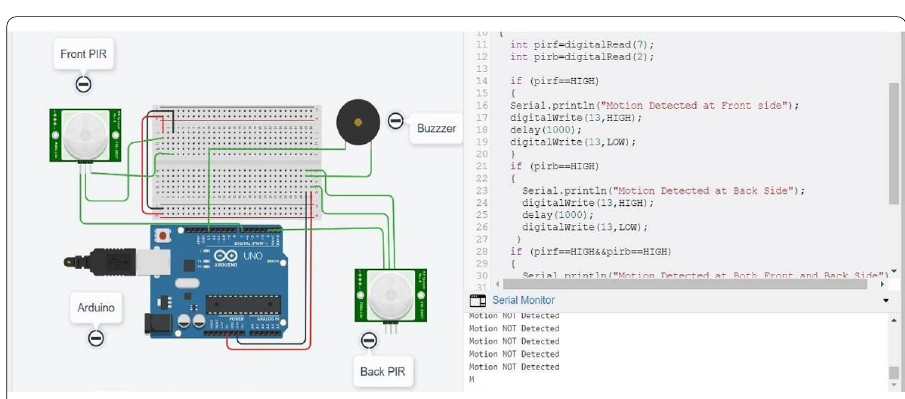
Fig. 7 Output at an instance when no object